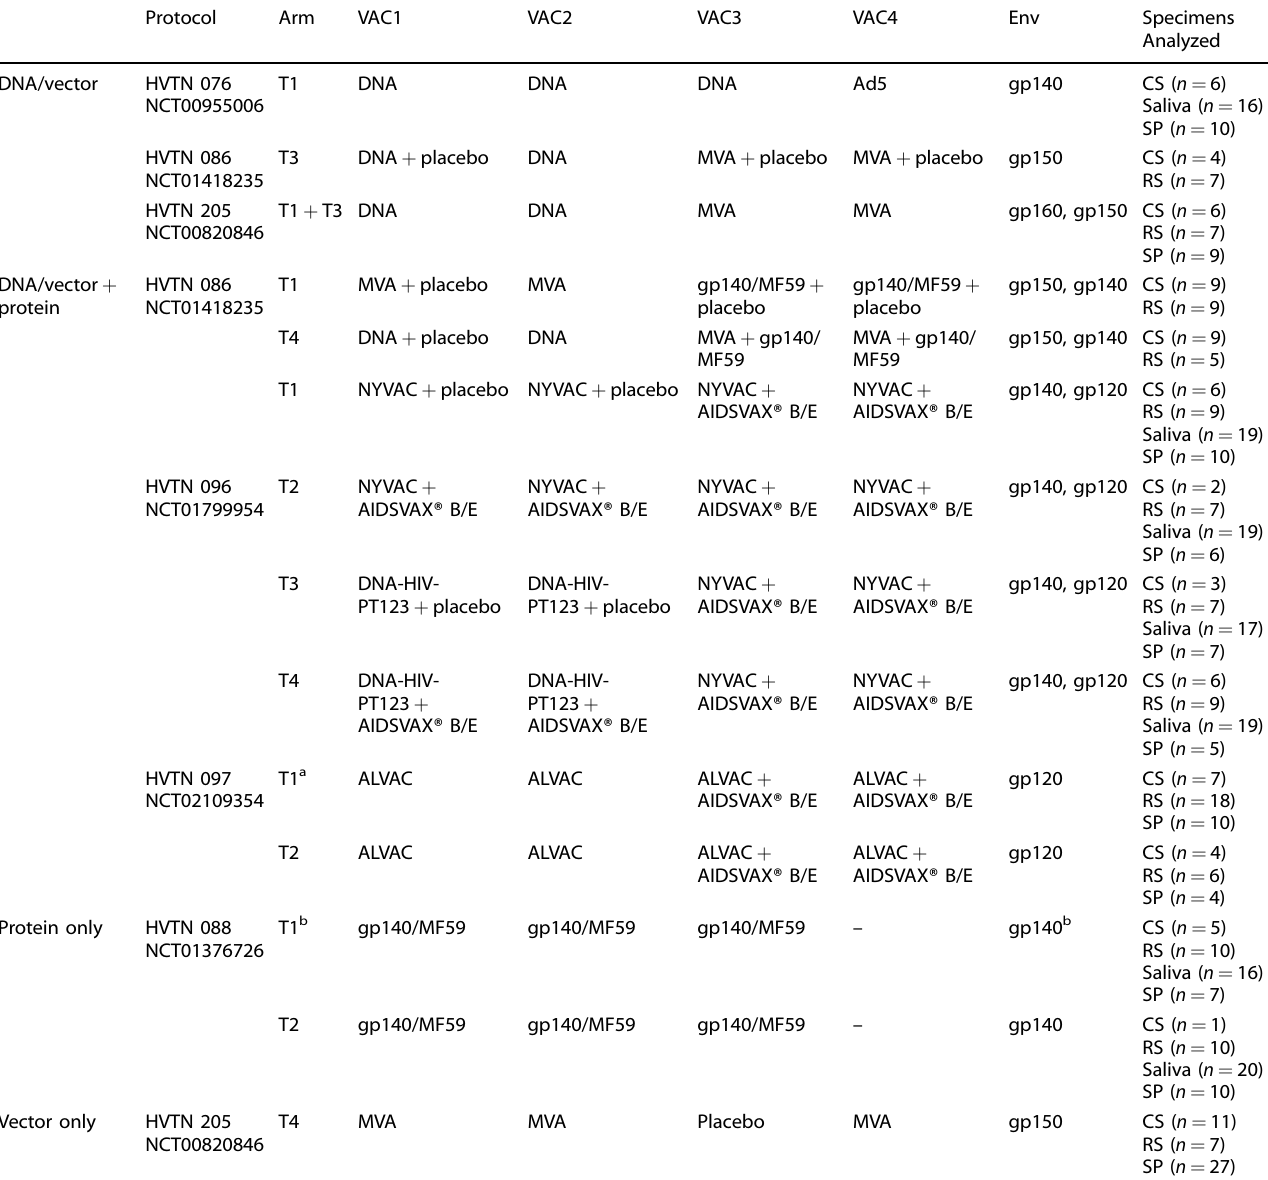
Table 1. HIV-1 vaccine regimen and dosing schedules. Protocol